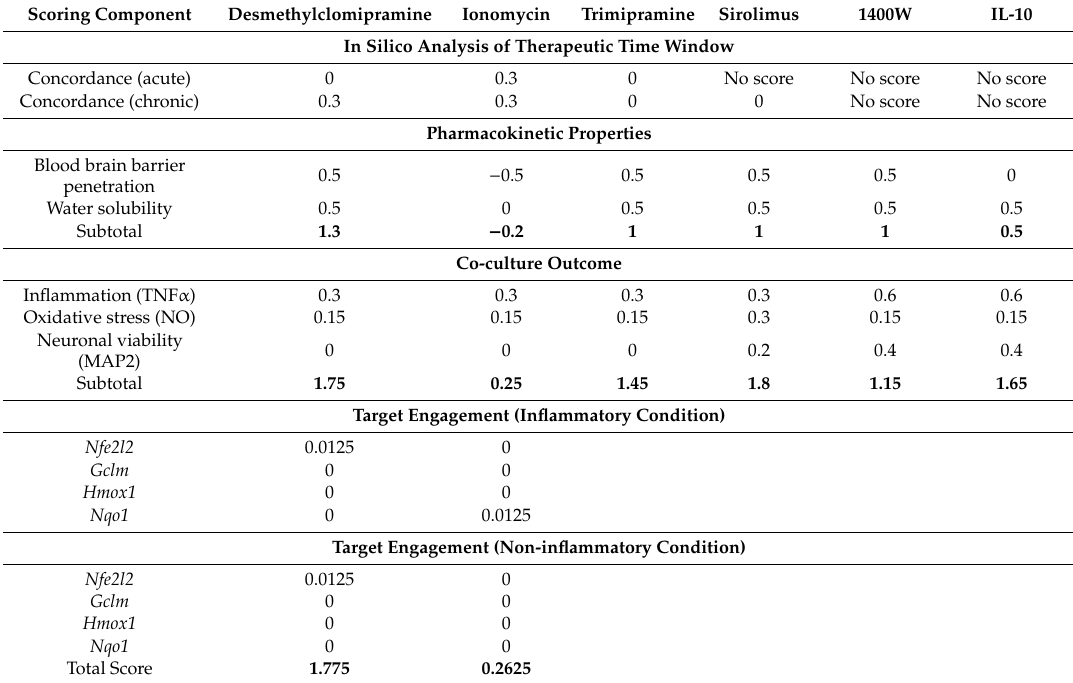
Table 4. Compound performance scores based on in silico and in vitro